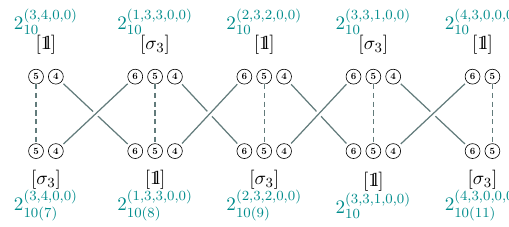
Figure 18 . T -duality chain of the E (9;5) -branes.